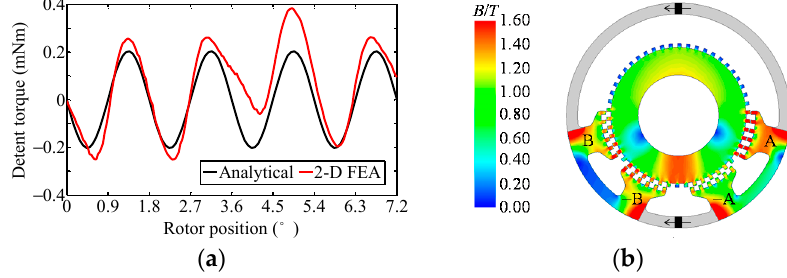
Figure 17. Comparison of detent torque of sub-motor1 by analytical method and 2-D FEA. ( a ) Detent torque; ( b ) No-load magnetic field distribution of simplified 2-D equivalent model of sub-motor1.